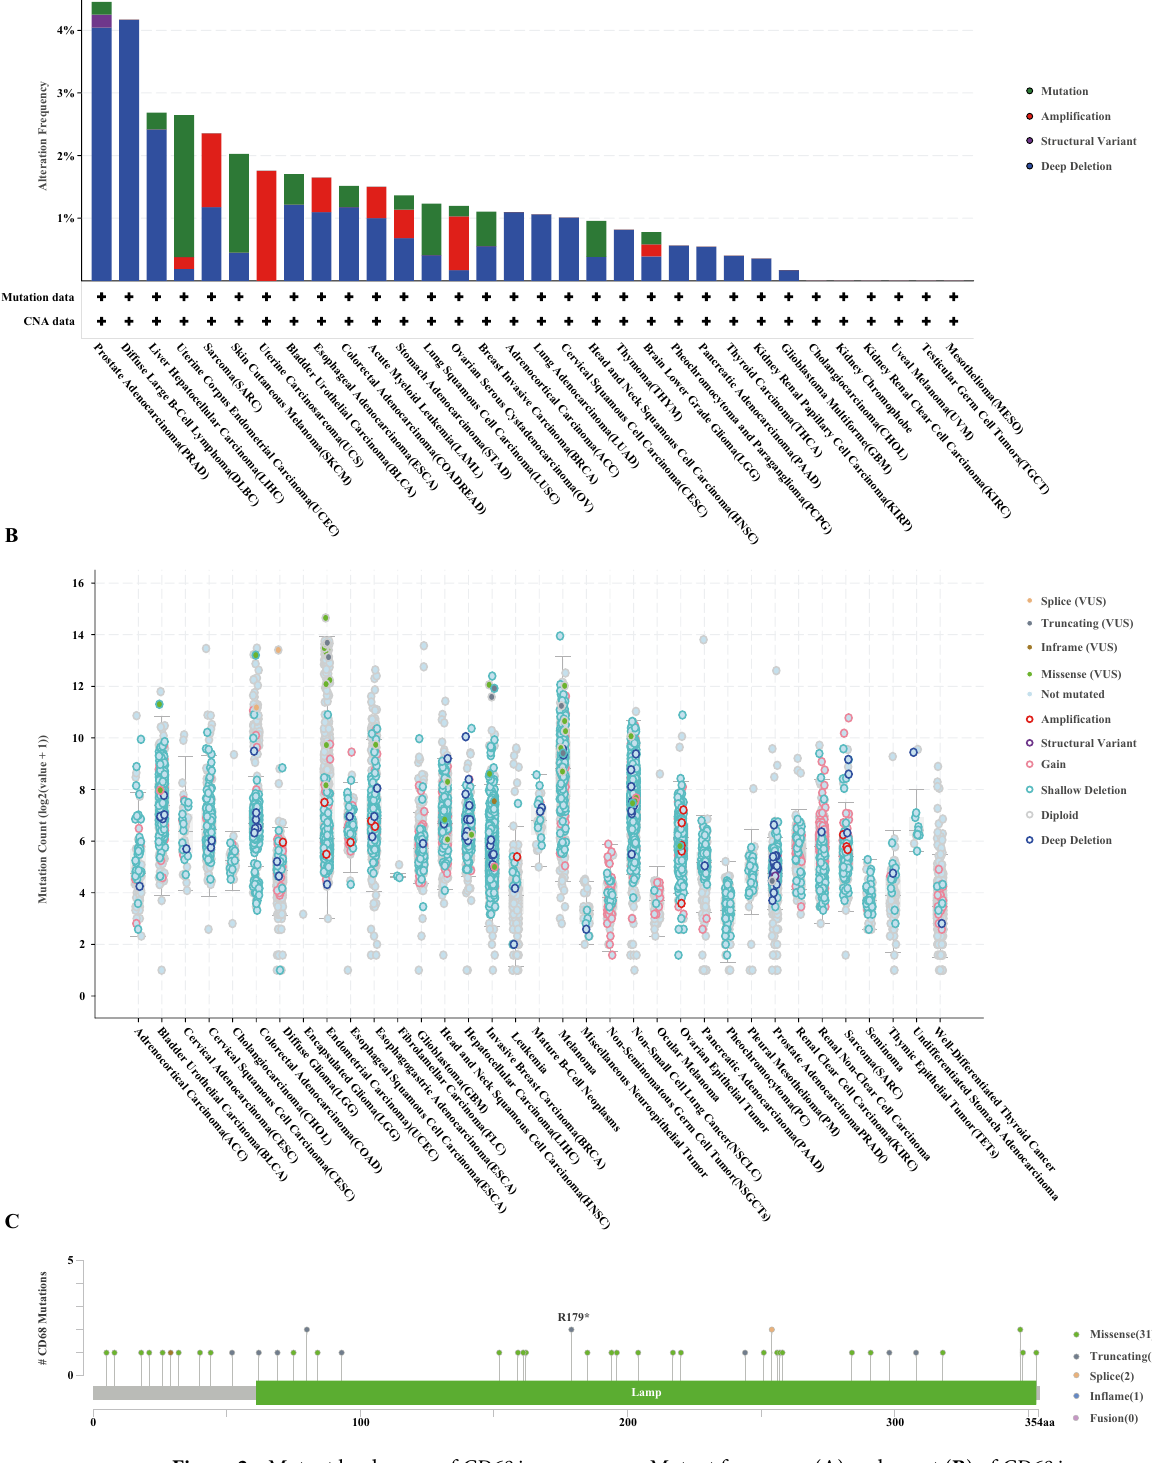
Figure 2. Mutant landscapes of CD68 in pan-cancer. Mutant frequency ( A ) and count ( B ) of CD68 in pan- cancer from the TGCA database based on cBioPortal analysis. Mutation aspect of CD68 in pan-cancer across protein domains ( C